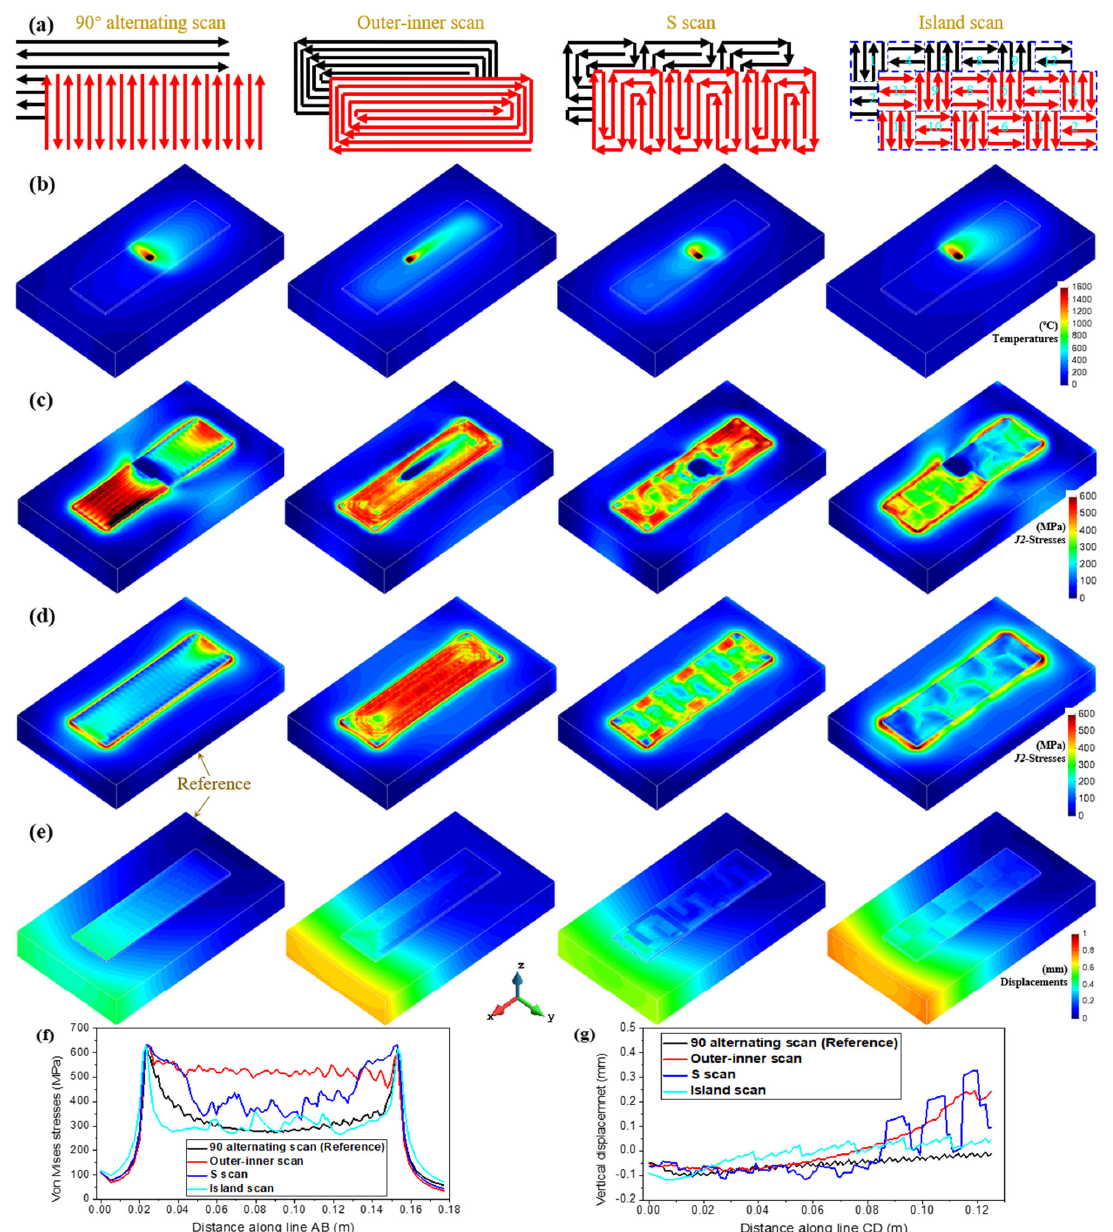
Figure 5. Rectangular block: ( a ) scan patterns; ( b ) temperature and ( c ) von Mises stress during the deposition of the 2nd layer; ( d ) residual stresses; ( e ) final distortions (displacements norm); ( f ) residual von Mises stresses along the AB line at the baseplate top; ( g ) final vertical displacements along the CD line at the deposit top.